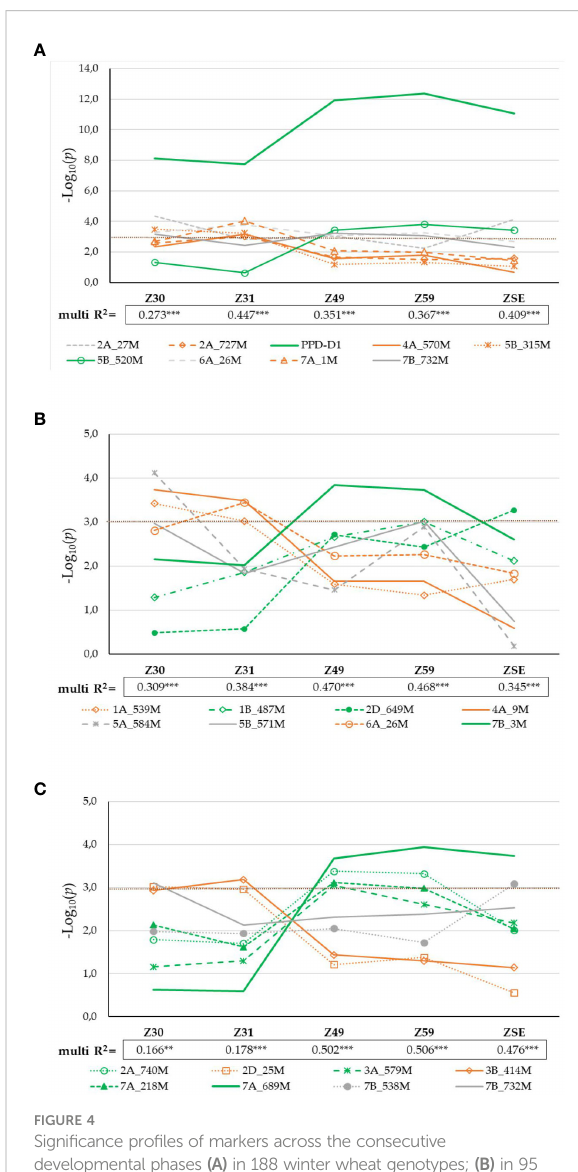
FIGURE 4 Signi fi cance pro fi les of markers across the consecutive developmental phases (A) in 188 winter wheat genotypes; (B) in 95 PPD-D1 insensitive wheat genotypes; and (C) in 93 PPD-D1 sensitive wheat genotypes. The LOD values originate from the GWA.